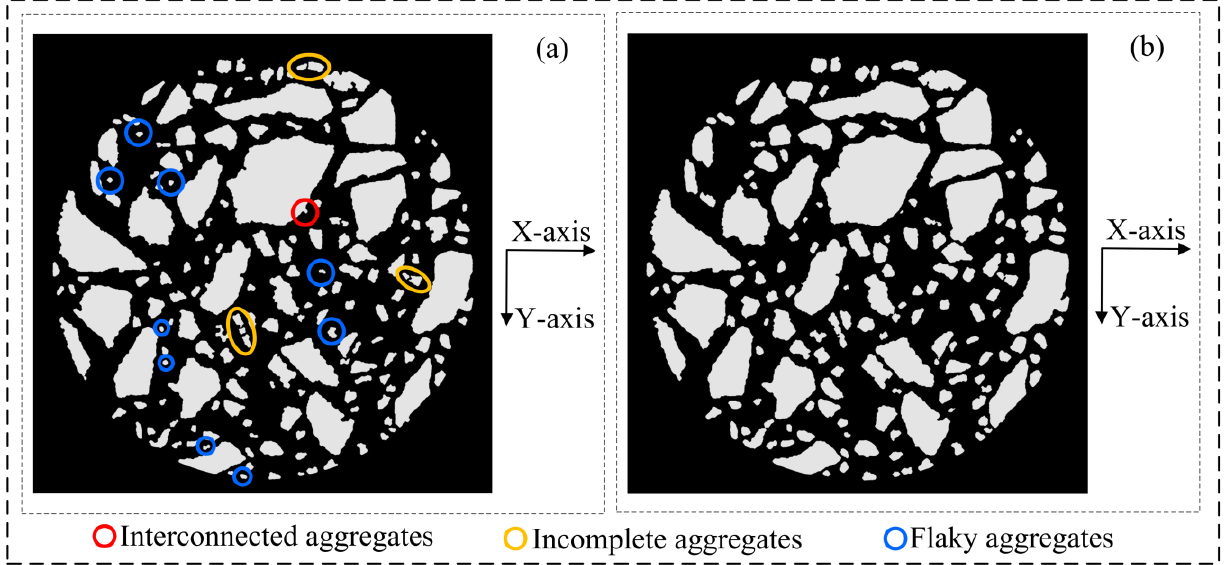
Figure 13. Asphalt concrete 3D voxel model sections (XY section): ( a ) before Z-axis multiple correction (corresponding to Figure 10a); ( b ) after Z-axis multiple correction (corresponding to Figure